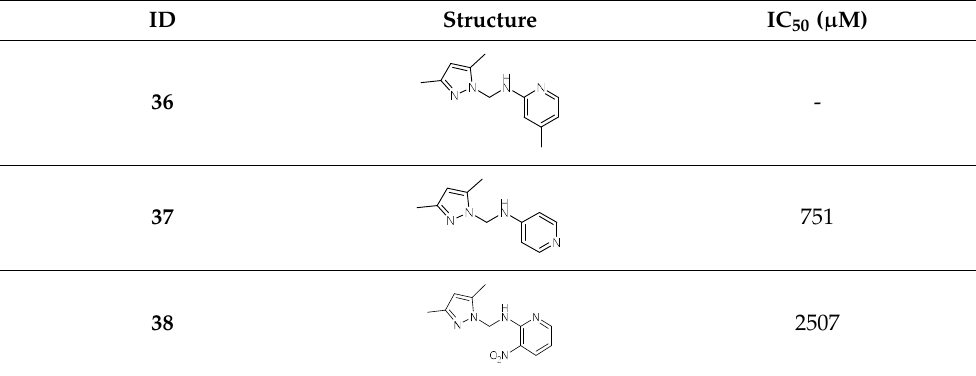
Table 6. IC 50 values of the tested pyrazolic compounds against F.o.a.